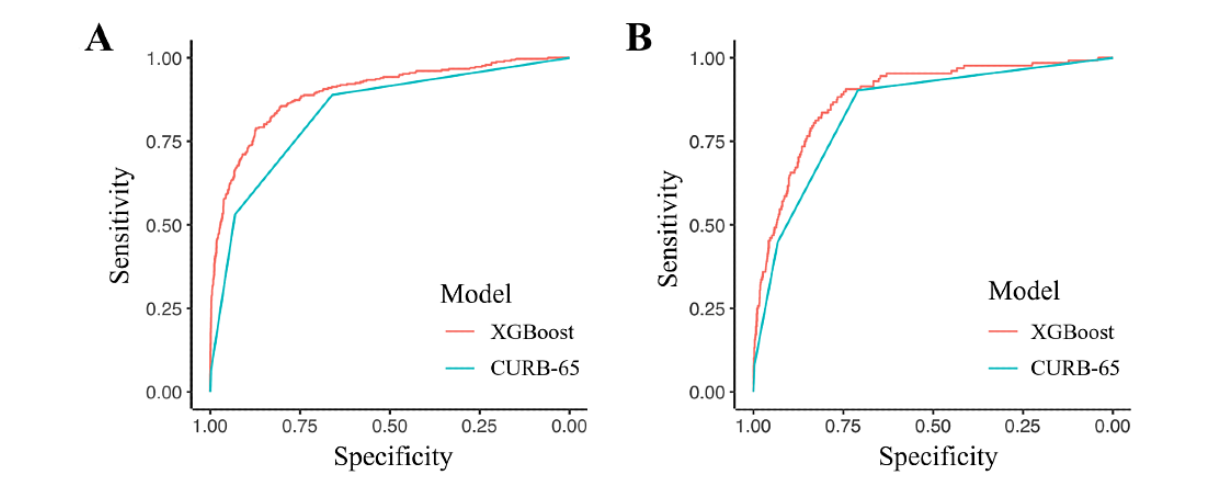
Figure 2. Receiver operating characteristic curves for the machine learning model (XGBoost) and the CURB-65 (confusion, urea, respiratory rate, blood pressure, and 65 years of age or older) score for predicting patients requiring intensive care. (A) Comparison in the derivation group, where the area under the receiver operating characteristic (AUC) curves were 0.897 for the gradient boosting machine model, and 0.836 for the CURB-65 score ( P <.001). (B) Comparison in the temporal external validation group, where the AUC were 0.885 for the machine learning model, and 0.843 for the CURB-65 score ( P